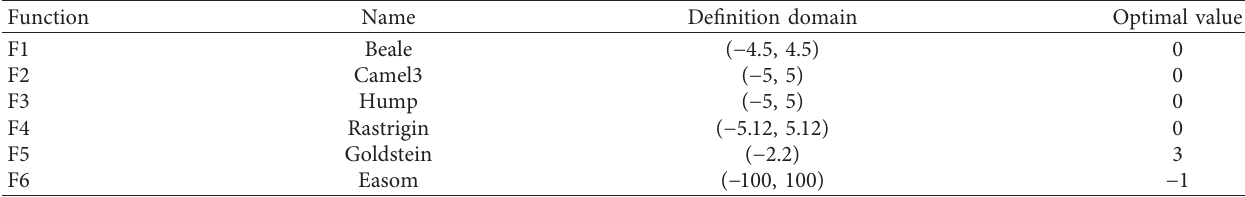
Table 1: Benchmark function definition domain and optimal value.